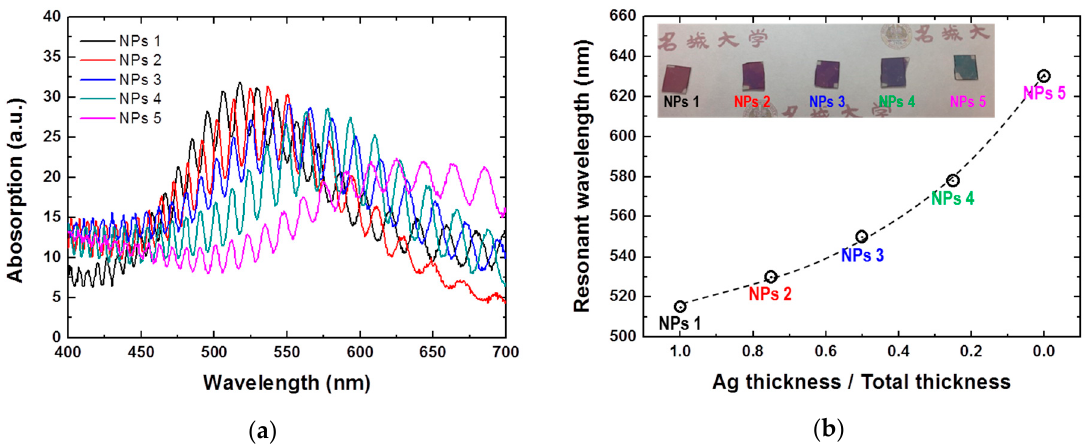
Figure 3. ( a ) Absorption spectra for NPs 1, NPs 2, NPs 3, NPs 4, and NPs 5 on the u-GaN layer and ( b ) the resonant wavelengths of the LSP modes for NPs 1, NPs 2, NPs 3, NPs 4, and NPs 5 on the u-GaN layer. The inset picture shows di ff erent colored samples due to the di ff erent absorption characteristics of each NP.